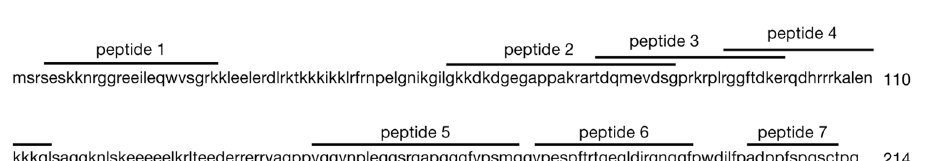
Figure 3. Peptides designed to HDV large antigen for serology assay. Consensus sequence of HDV large antigen from 230 sequences. Indicated are regions designed as peptides.